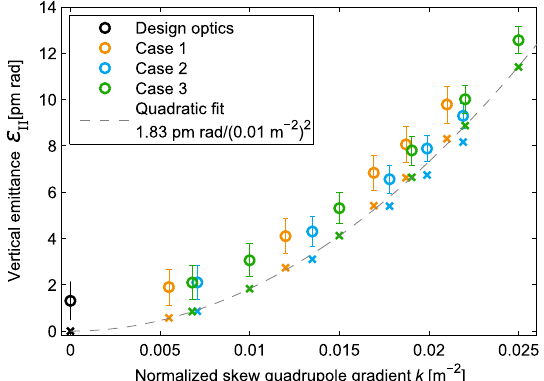
FIG. 5. Vertical emittance scales with skew quadrupole gradient squared. Ideal lattice (x) and error lattice (o) with standard deviations from 10 error seeds. Only the k of the strongest skew quadrupole involved in each case is considered.